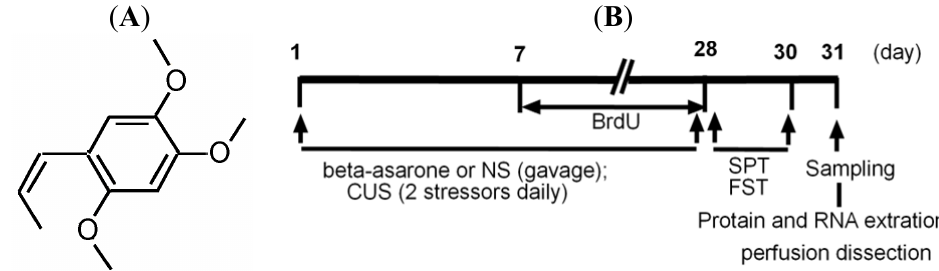
Figure 1. ( A ) Chemical structure of β -asarone and ( B ) protocol used in this